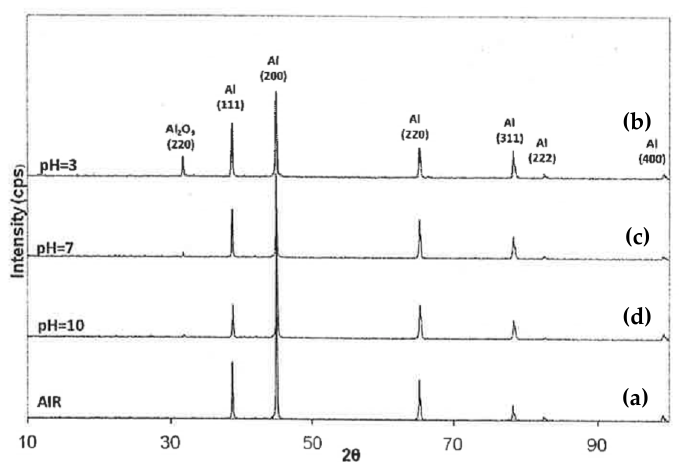
Figure 7. X-ray diffraction (XRD) analysis of the surface of T6 treated 6082 aluminum alloy, after SSRT testing in ( a ) air, ( b ) pH = 3, ( c ) pH = 7 and ( d ) pH = 10.